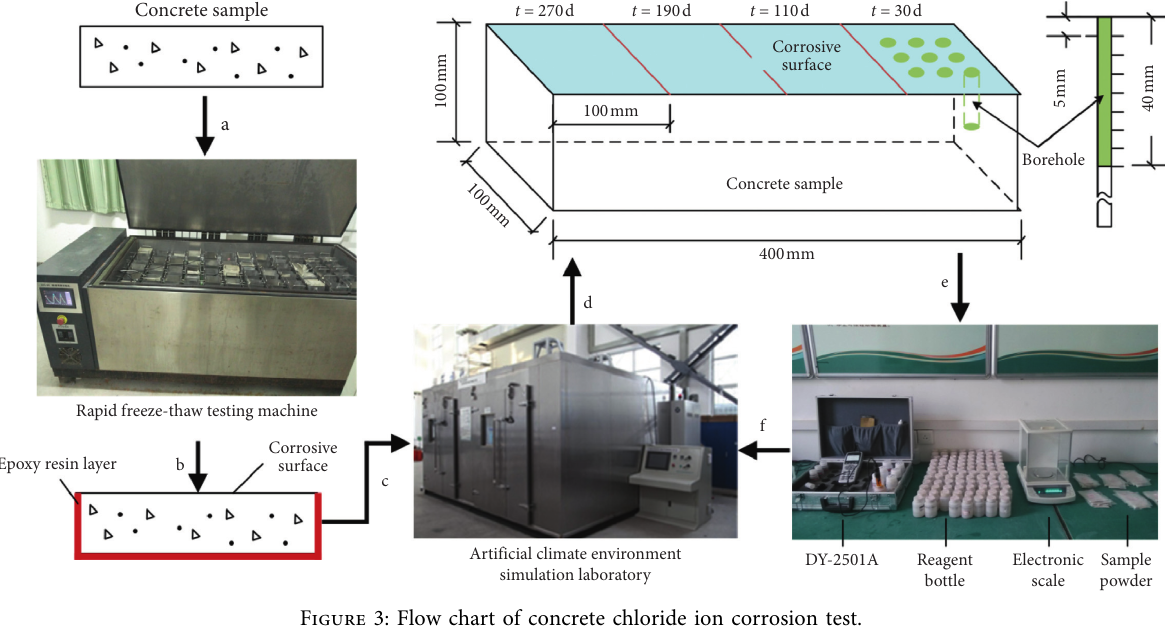
Figure 3: Flow chart of concrete chloride ion corrosion